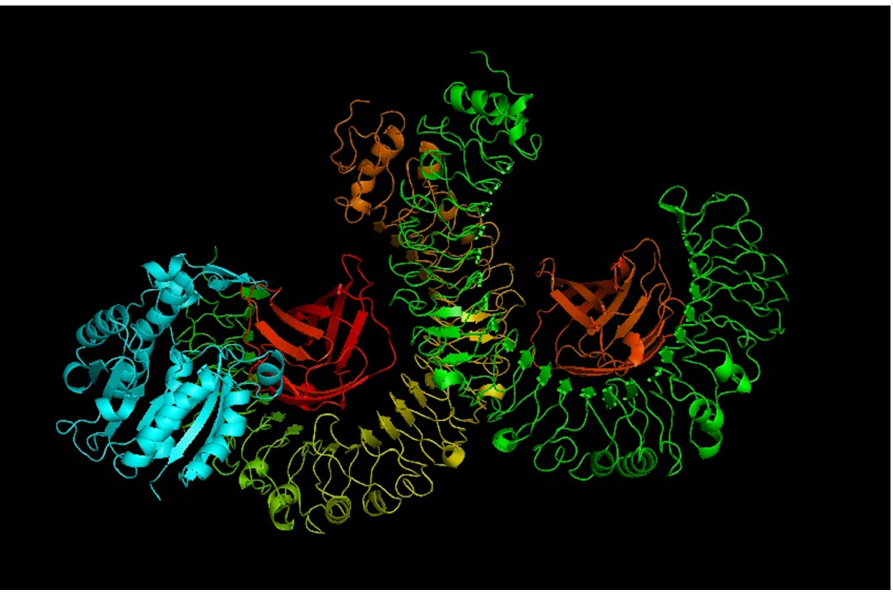
Figure 8. The docked complex of the vaccine model and the TLR4 immune receptor. The vaccine protein is shown in blue, while the rest of the residues are the TLR4 receptor.